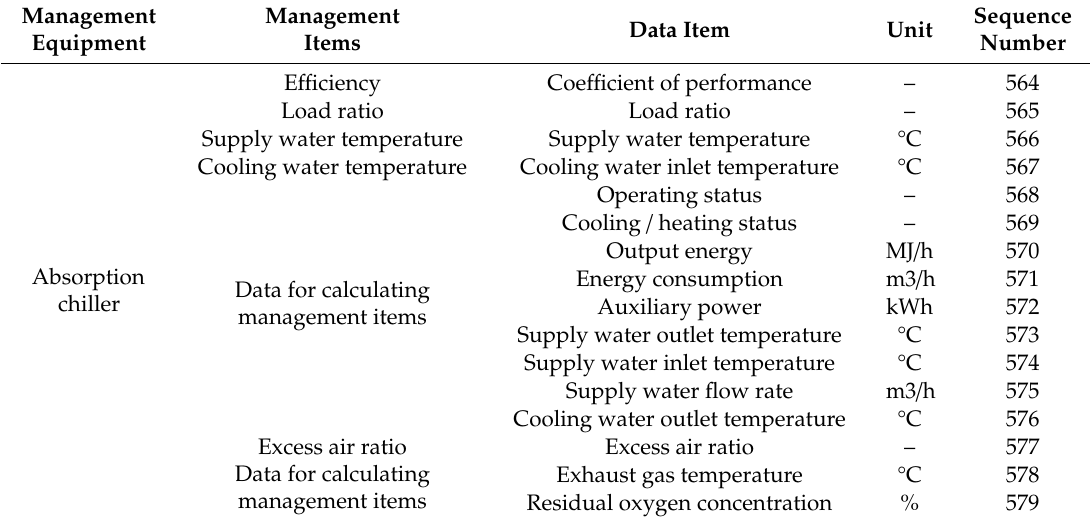
Table 1. Example of the standard format of data items.